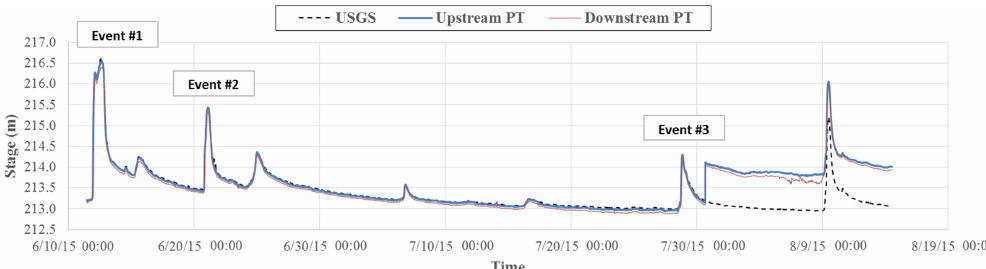
Figure 3. A full spectrum of hydrological events during the measurement campaign. The horizontal axis shows the time stamp and the vertical axis represents stages in the NAVD system. The selected three events are indicated in the figure and each graph represents recorded data from USGS, upstream PT, and downstream PT sensors.